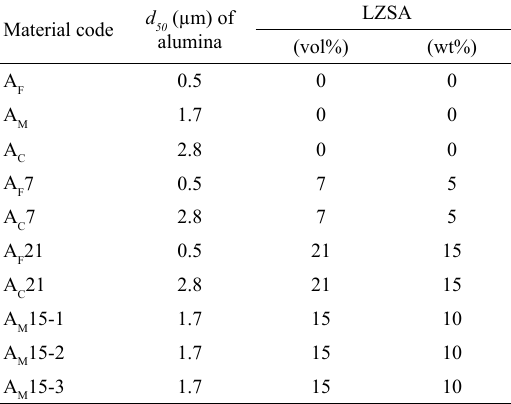
Table 2. Experimental design with the combinations among each factor. Material